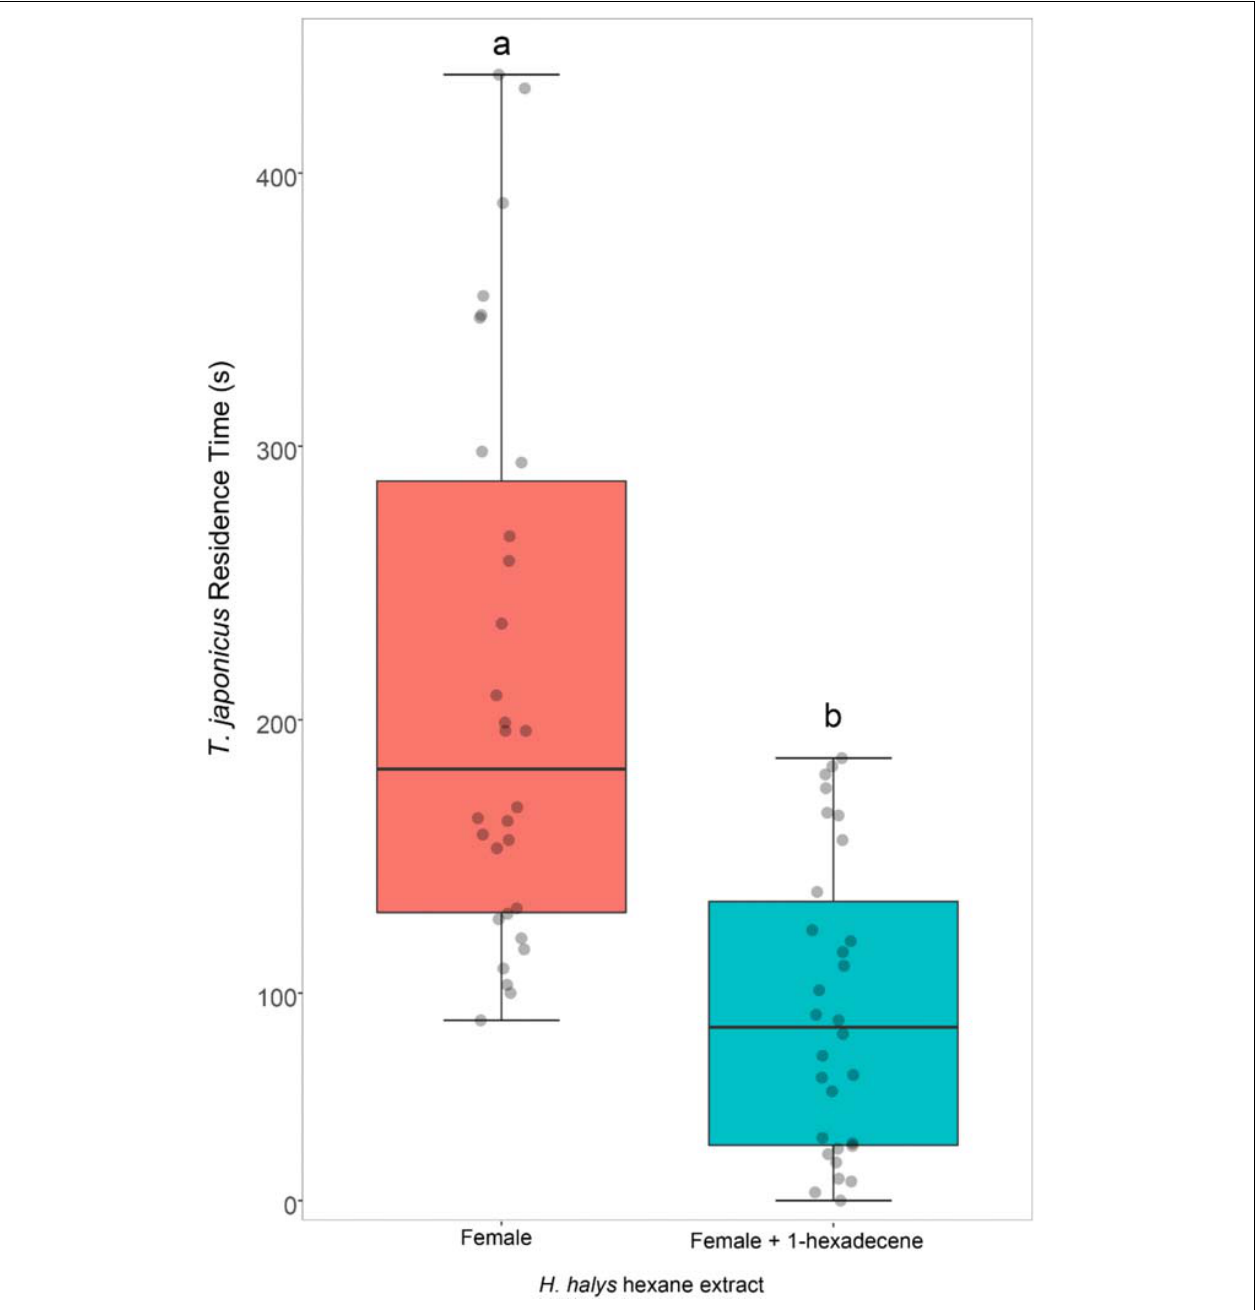
FIGURE 3 | Response of Trissolcus japonicus females to substrate treated with hexane extract of Halyomorpha halys females (red box) or with hexane extracts of H. halys females blended with 1-hexadecene (blue box). Bold horizontal lines show medians, boxes contain the 25 th –50 th percentiles, whiskers show the upper and lower quartiles and points represent individual replicates. Different letters indicate statistically significant difference ( P < 0.05,